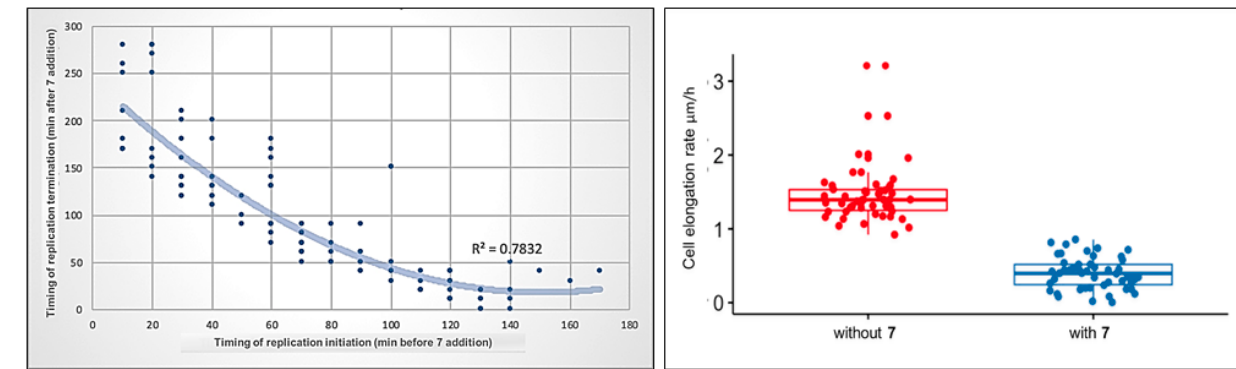
Figure 10. Correlation between the timing of compound 7 addition and replication initiation or termination during the cell cycle of M. smegmatis DnaN-EGFP (JH01) ( left ). M. smegmatis DnaN-EGFP (JH01) cell elongation ( right ) during treatment with compound 7 (blue dots) and before treatment during growth in optimal conditions (red dots). The difference was statistically significant with p = 1.4 × 10 − 28 , n = 50.